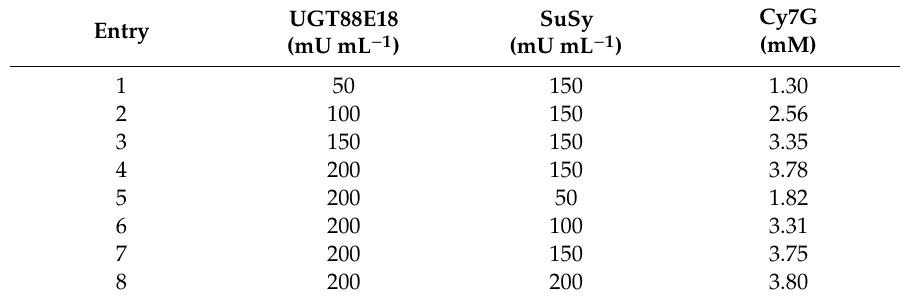
Table 2. E ff ect of di ff erent enzyme ratios on product yields of calycosin-7-O- β -D-glucoside